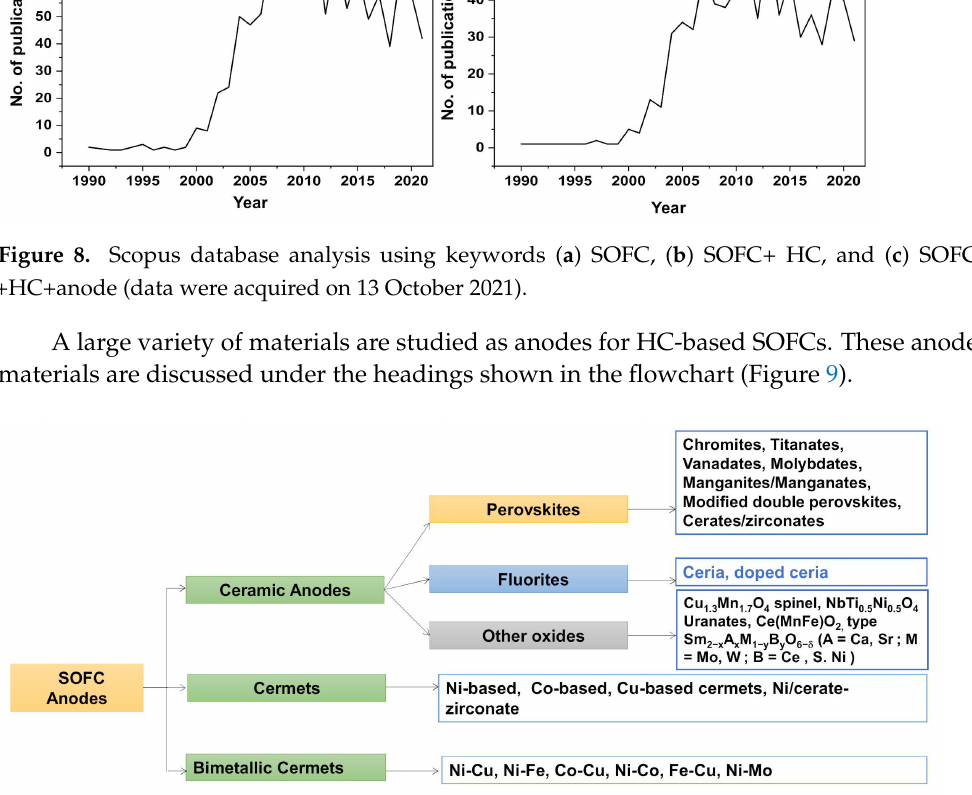
Figure 9. Flowchart showing the classification of HC-compatible SOFC